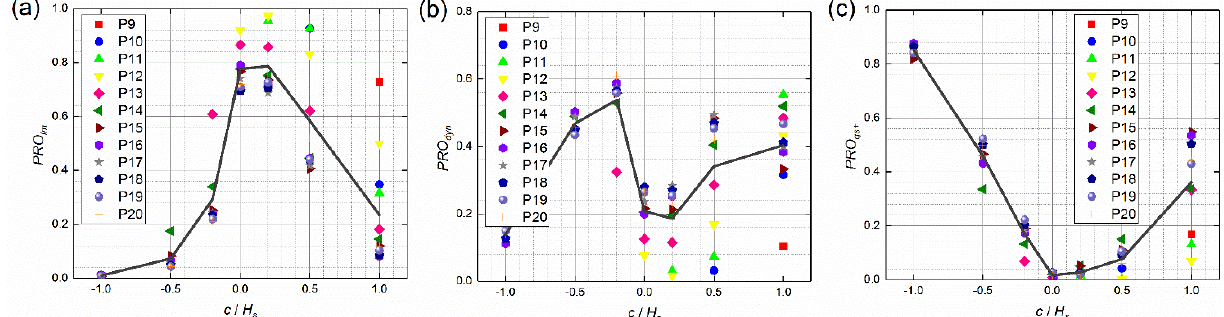
Figure 14. Influence of relative structural clearance ( c / H s ) on the probabilities of three types of wave impact on vertical wall portion for incoming significant wave height of 0.10 m (trials T3, T8, T13, T18, T23, T28, and T33): ( a ) impulsive probability PRO im ; ( b ) dynamic probability PRO dyn ; ( c ) quasi-static probability PRO qs+ .